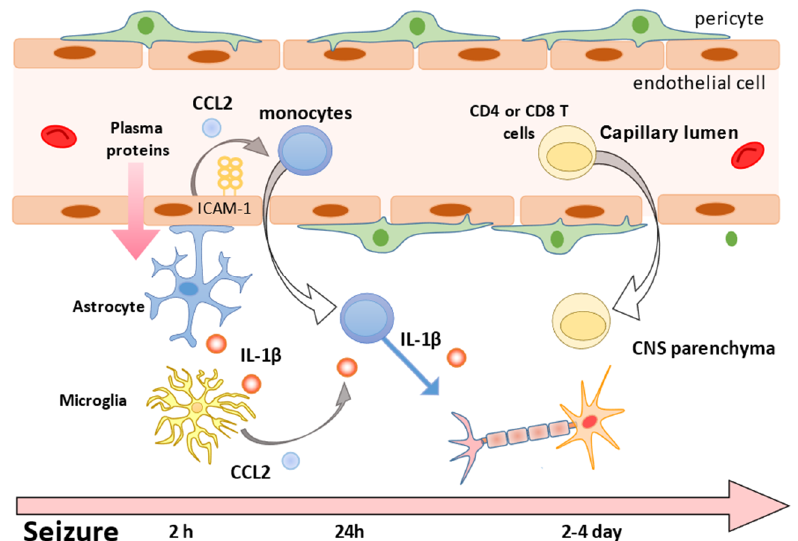
Figure 1. Representation of associations between the peripheral immune cells and brain in experimental models investigating epileptogenesis. Table 3. Time course of innate and adaptive immune responses in experimental models of epilepsy.